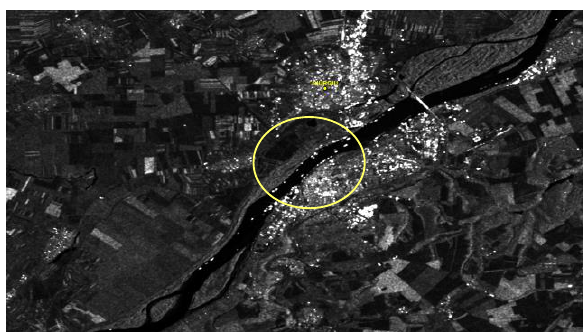
Table 1. List of Sentinel-1 data